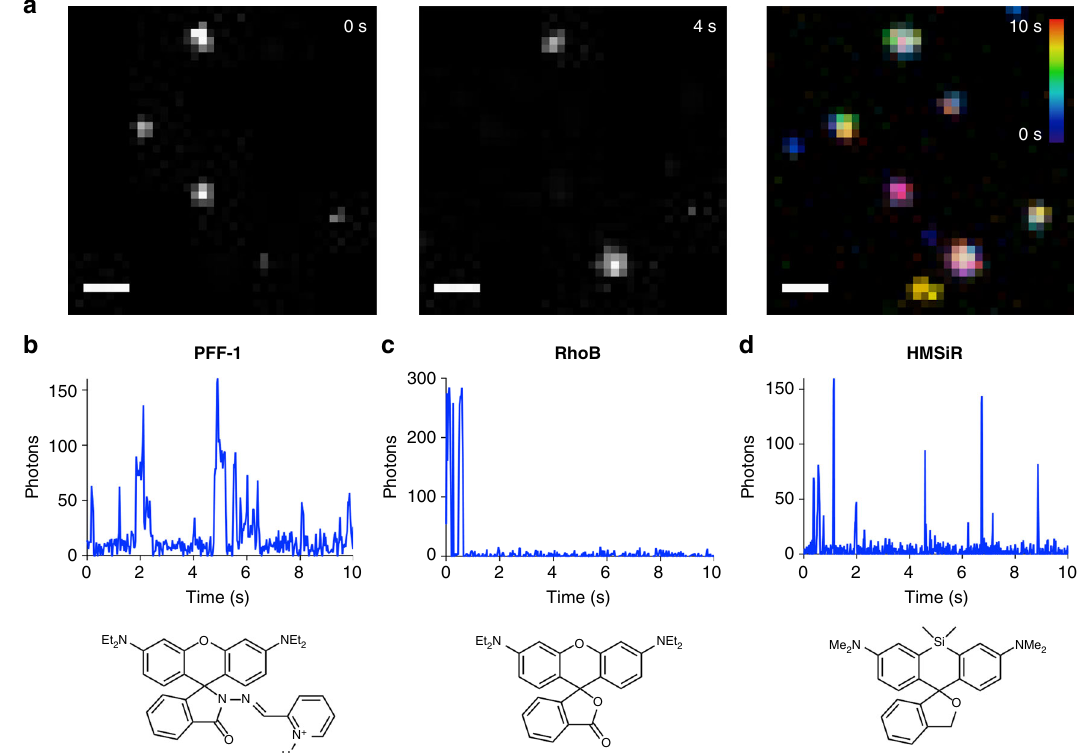
Fig. 3 Single-molecule imaging of PFF- 1 , rhodamine B (Rho B), and HMSiR in polymer fi lms. a Examples of camera frames in which single molecules of PFF- 1 were observed in the fl uorescent state, and average intensity over all frames collected during a 10 s acquisition, color-coded according to time. Most spots in the color-coded image display multiple colors because single molecules emit photons at various time points. b Kymograph of a single molecule of probe PFF- 1 switching for 10 s. c Kymograph of a single molecule of Rho B. No switching is observed, only irreversible transformation into a dark state. d Kymograph of a single molecule of probe HMSiR blinking spontaneously for 10 s. The chemical structure of each compound is displayed under the indicated panel. Scale bar in panel ( a ) 1 μ